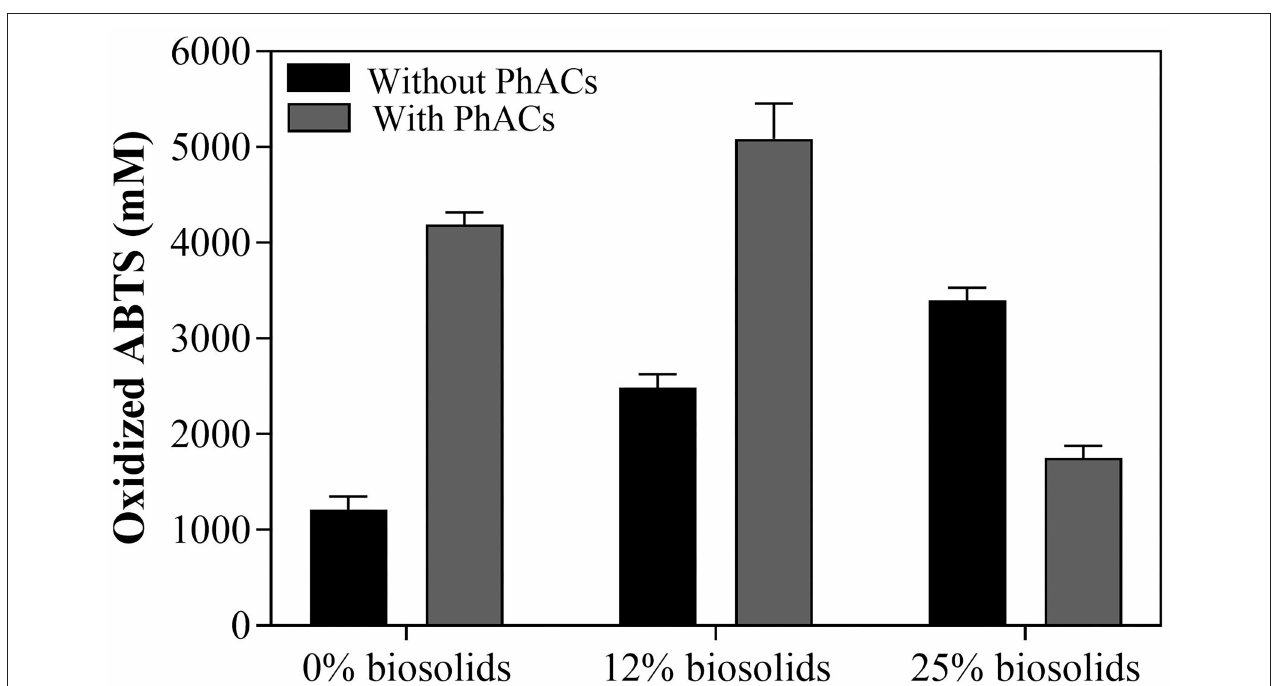
FIGURE 1 | LAC production over the 35-day growth based on the daily enzymatic volumic activity with T. hirsuta in PhACs-free biosolid-based growth and in PhACs-contaminated biosolid-based growth.